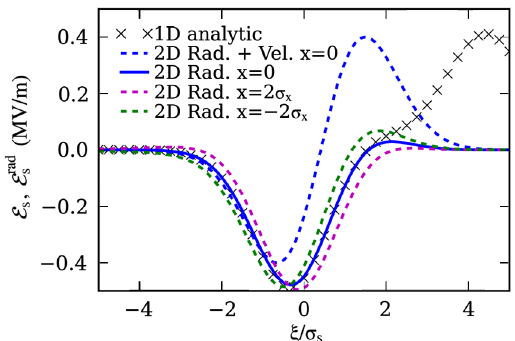
FIG. 12. Comparison of the transient longitudinal CSR field E (blue dashed curve) and E rad